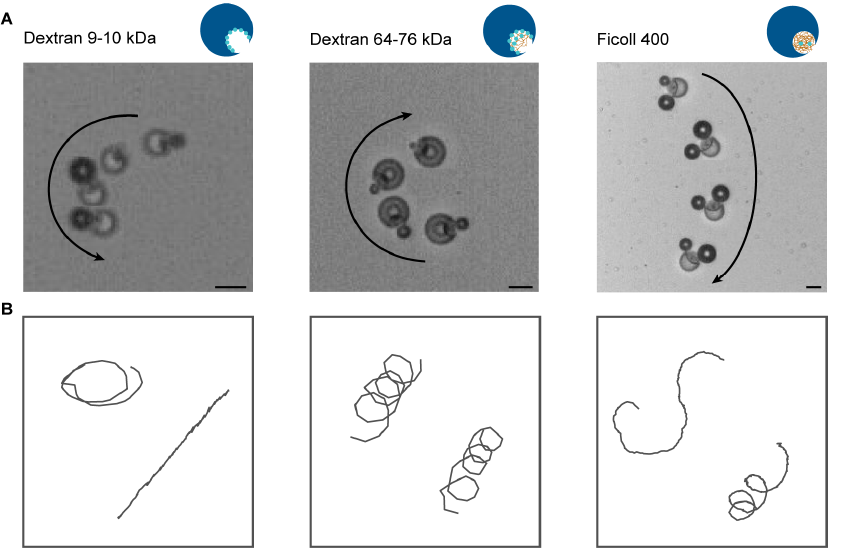
Figure 3. ( A ) Bright field microscopy overlay of bubble propulsion of the three different polysac- charide systems with an interval of 0.5, 1, and 6 s for dextran 10 kDa, 70 kDa and Ficoll 400 kDa, respectively. ( B ) Typical trajectories of each motor system. Scale bar is 20 µm.